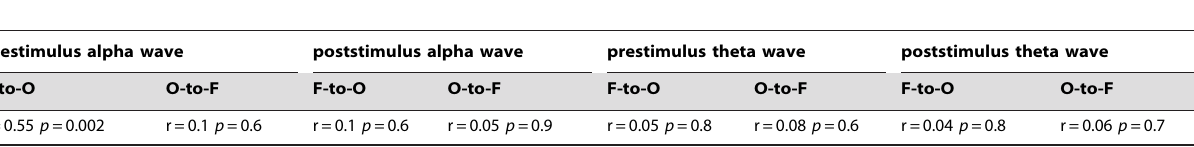
Table 2. Correlation coefficient ( r ) and corresponding p values between the wave index and reaction speed index for pre- and post-stimulus alpha and theta waves traveling in F-to-O and O-to-F